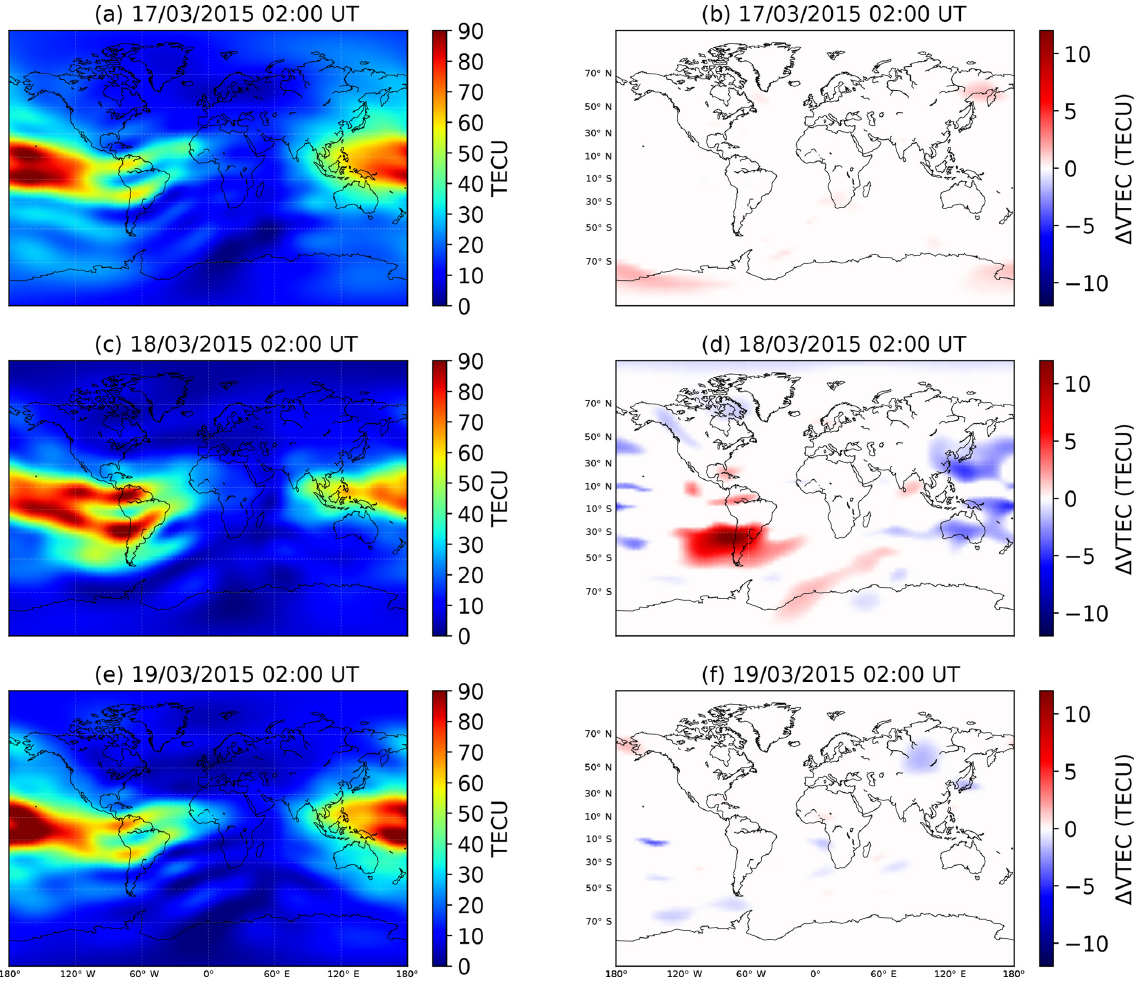
Figure 6. (a) Global ionospheric maps for 17, 18 and 19 March 2015 at 02:00UT. (b) Differential VTEC maps for 17, 18 and 19 March 2015 at